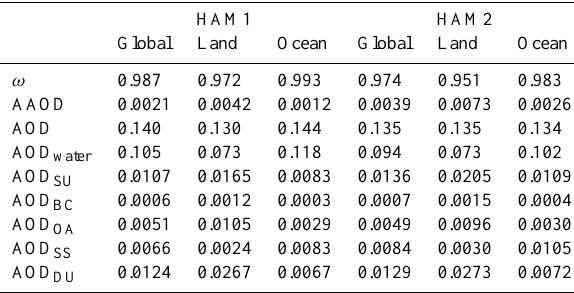
Table A2. Globally (90 ◦ S–90 ◦ N) and regionally (land, ocean) averaged annual mean single scattering albedo ( ω ), absorption aerosol optical depth (AAOD) and total aerosol optical depth (AOD) in HAM1 and HAM2, and the contribution to AOD from different chemical